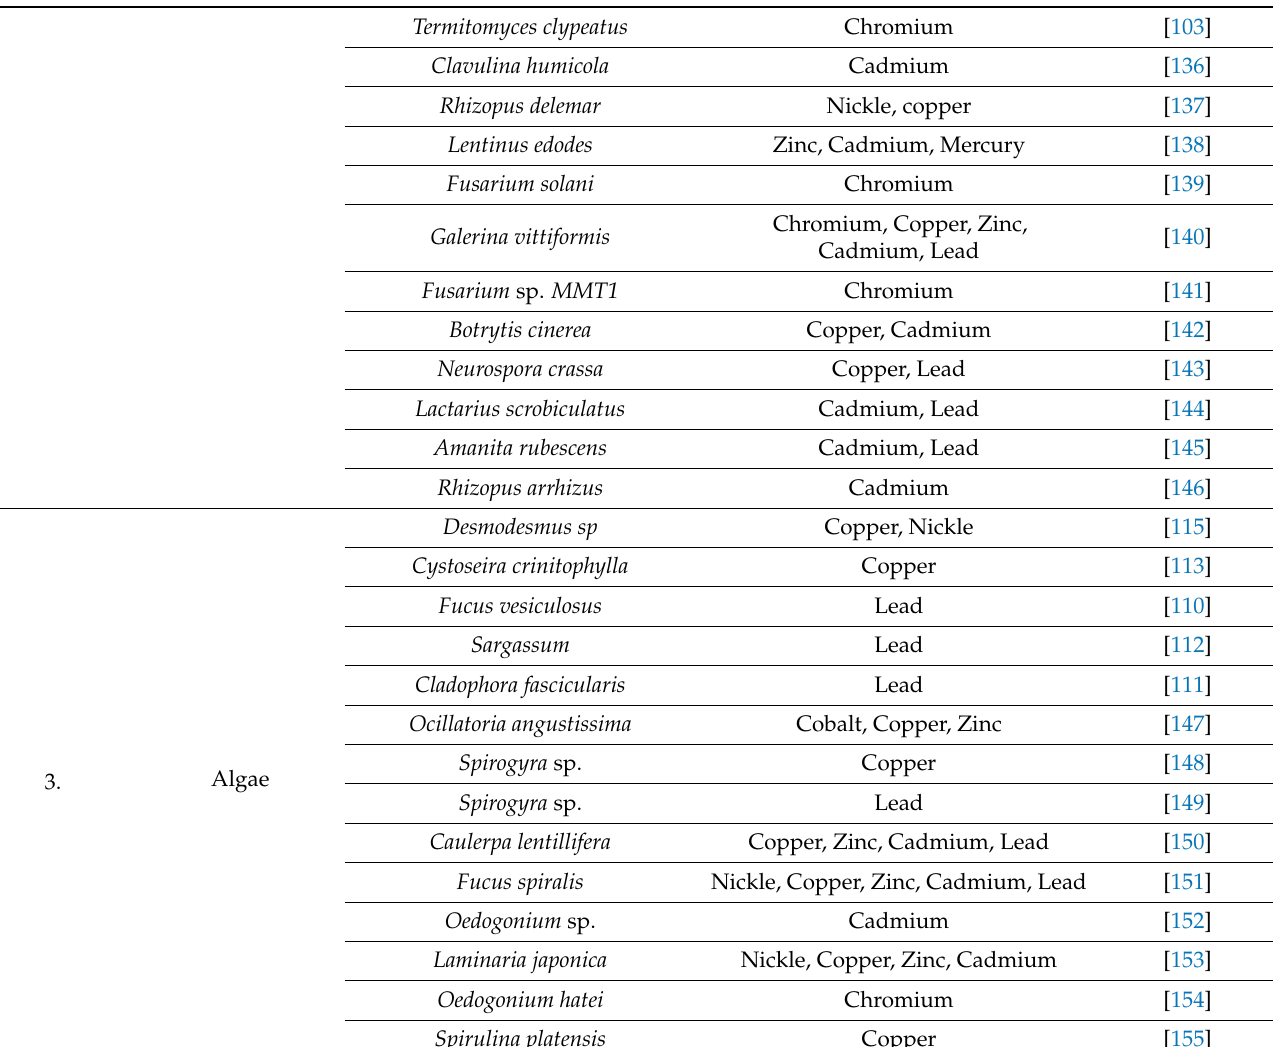
Table 1. Cont. Termitomyces